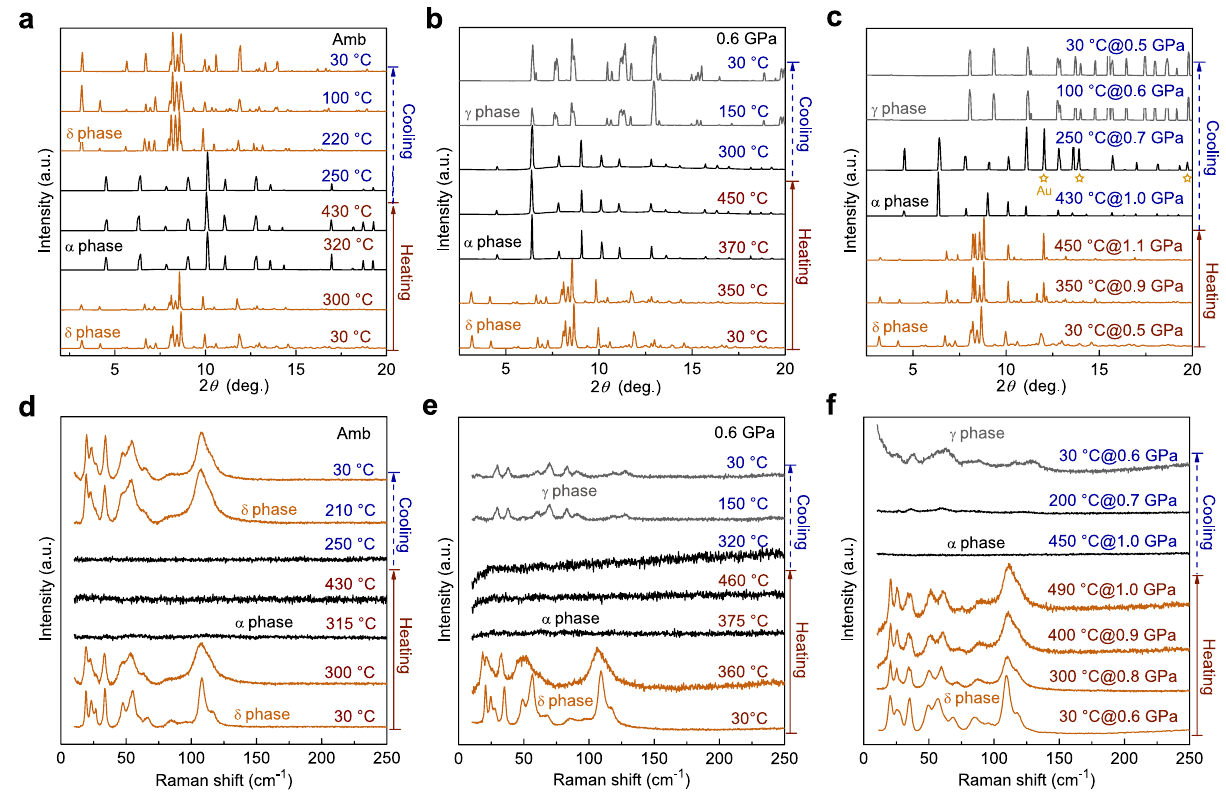
Fig. 2 X-ray diffraction (XRD) and Raman spectra showing the effect of pressure on the structural transition of CsPbI 3 along with thermal treatments. a – c XRD results ( λ = 0.4959Å) of CsPbI 3 along heating and cooling cycles at ambient pressure ( a ), 0.6 GPa ( b ), and varying pressures ( c ). The sample remains in a crystalline state up to the highest temperature studied in each cycle. The intensity differences of XRD patterns for α - and γ -CsPbI 3 could be a result of different grain sizes and orientations due to the grain growth to highly textured, coarse grains at high temperatures. d – f Raman spectra of CsPbI 3 along heating and cooling cycles at ambient pressure ( d ), 0.6 GPa ( e ), and varying pressures ( f ), con fi rming the structural transitions observed from XRD